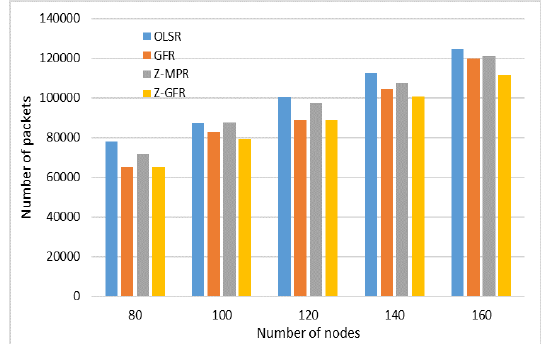
Figure 15. Number of packets transmitted to the MAC layers of